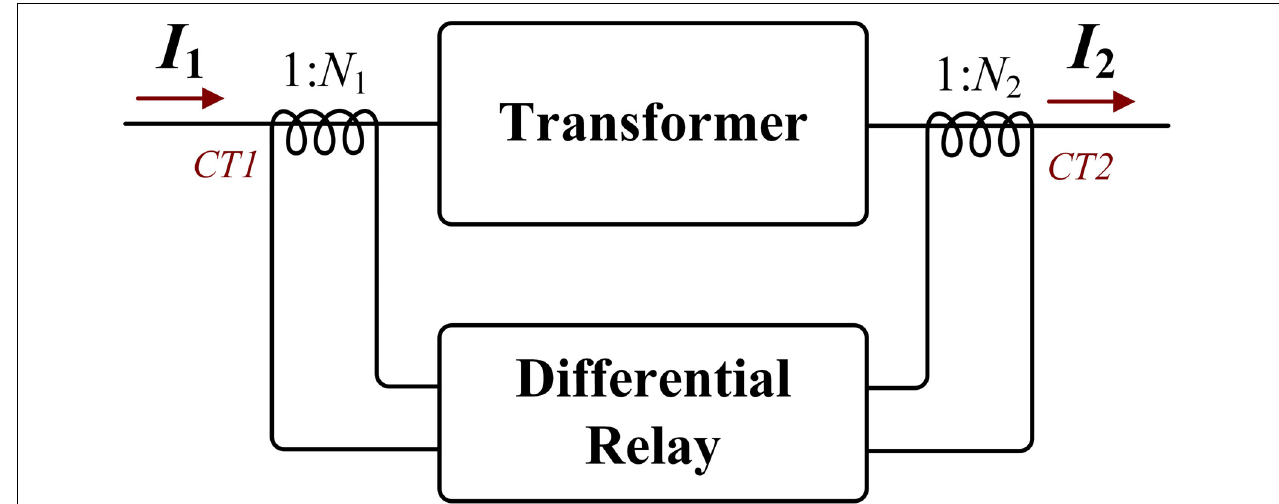
FIGURE 4 | A typical differential relay protection for a single-phase